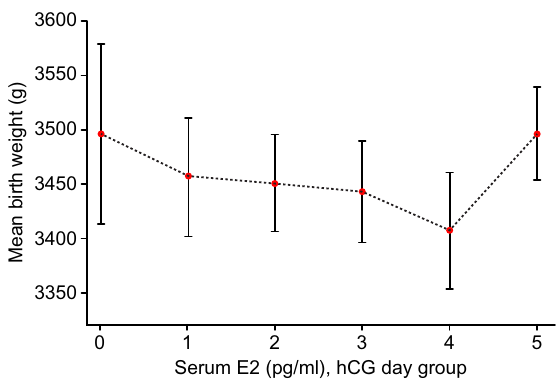
Figure 1. Relationship between serum E2 levels and neonatal